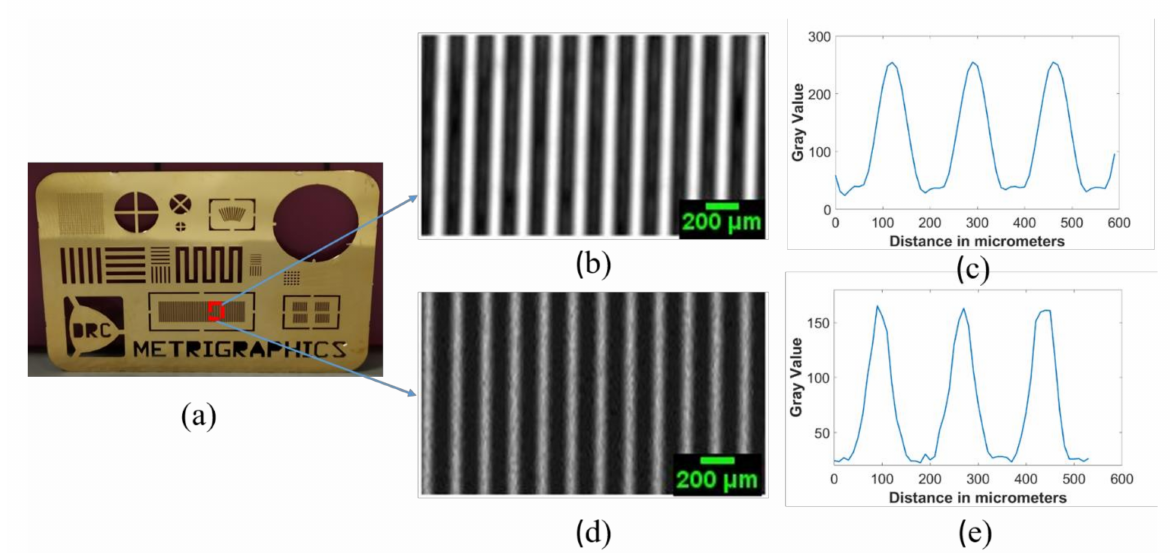
Figure 10. ( a ) Optical image of the resolution chart; ( b ) C-scan image from commercial transducer; ( c ) profile plot of the image taken from commercial transducer; ( d ) C-scan from in-house transducer; ( e ) profile plot of the image taken by in-house transducer. Scale bars with length 200 µ m are given in images ( b , d ) where each pixel has a 10- µ m physical